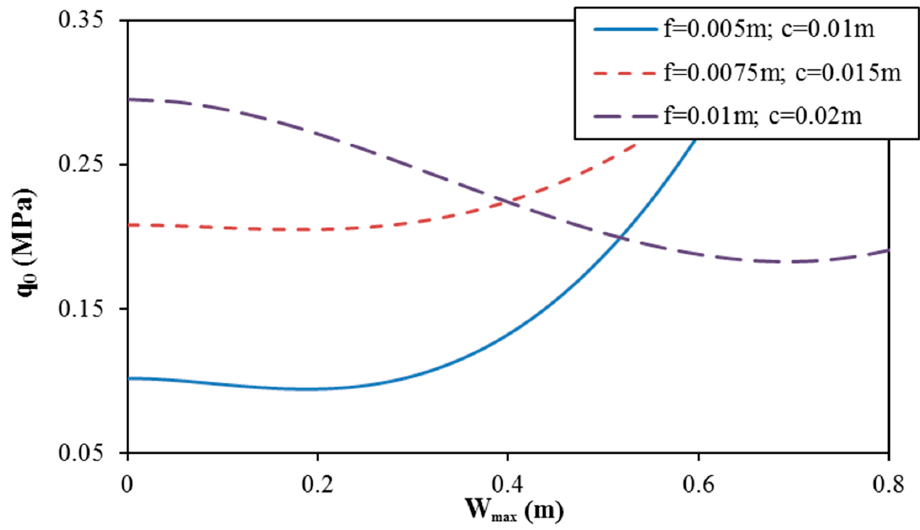
Figure 8. Effect of geometrical parameters of corrugation on the postbuckling curve of spiral corrugated UD-CNTRC cylindrical shells (trapezoidal corrugation, V ∗